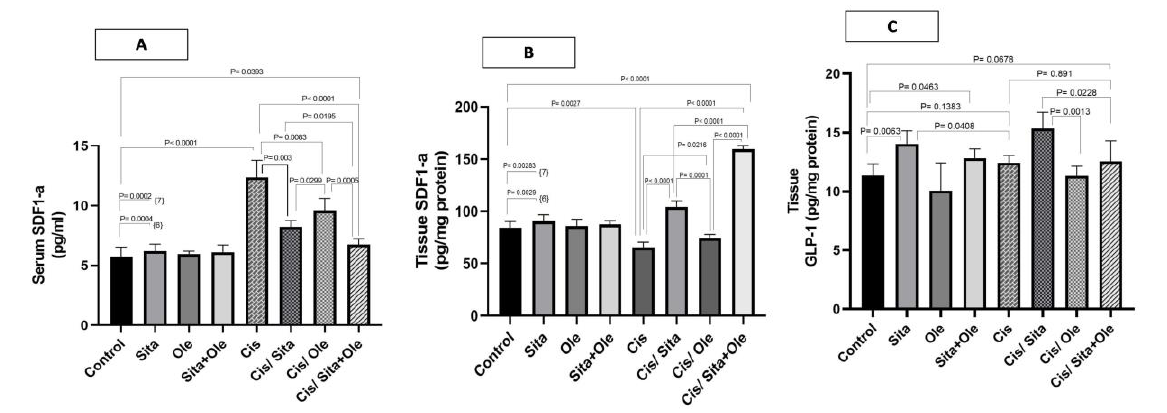
Fig. 2. Effect of cisplatin, sitagliptin, oleuropein and combination of them on some DPP4 substrates; A: SDF-1α in serum (pg/ml); B: SDF-1α in renal tissues (pg/mg protein); C: GLP-1 in renal tissues (pg/mg protein). Data are presented as means ± SD. P < 0.05 is considered statistically significant; one-way ANOVA followed by Bonferroni-corrected post hoc tests were